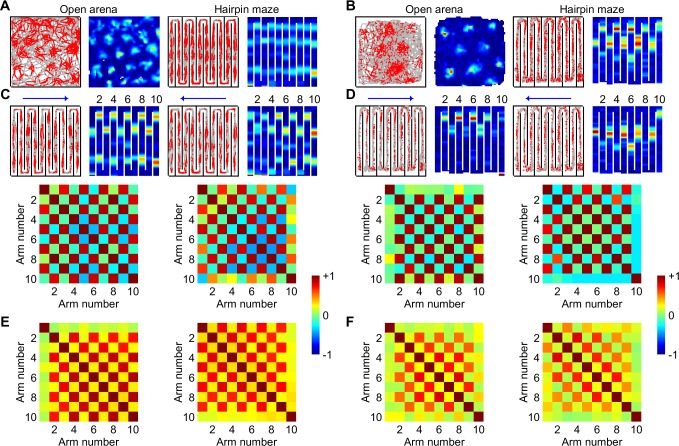
Fragmentation of grid cell maps in a multicompartment environment.Probabilistic (A, C) and rat (B, D) grid cell response patterns are both disrupted in a hairpin maze of the same dimensions as an open square arena (1.5 m × 1.5 m). Rate maps repeat across alternating arms but differed with the global running direction (easterly →, westerly ←), inconsistent with purely location-specific activity. Arm-arm rate vector correlations (10 cm bins along each arm axis) show checker-board patterns from individual probabilistic (C) and rat (D) grid cells. (E, F) Population correlation matrices showing similar alternating arm-arm rate relationships (n = 2,000 concatenated probabilistic grid cell rate maps (E), n = 105 from rat (F) using the first 20-minute session). Rat grid cell displays were constructed from data published previously [36], with permission from D. Derdikman, M.-B. Moser and E. Moser.